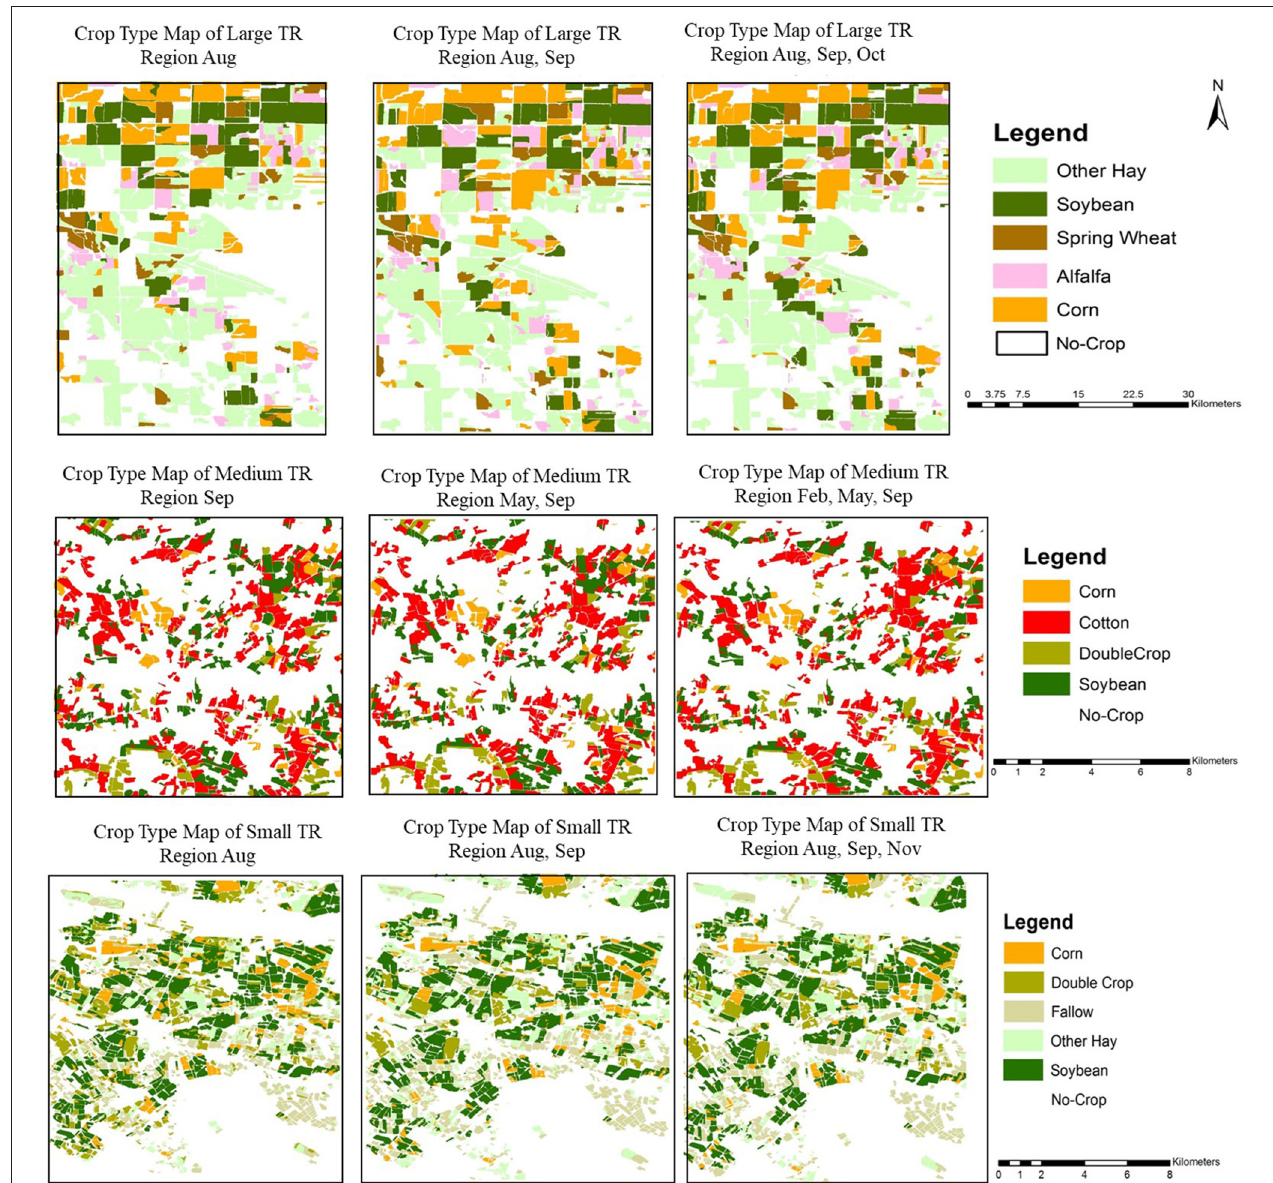
FIGURE 7 | Crop type maps of three TR regions produced from one, two, and three dates of satellite imagery in the large, medium, and small field sizes. In addition to providing additional spectral characteristics for mapping different crop types of a region, the multiple dates of satellite imagery help to identify the discrepancies and errors (e.g., omission or commission) that existed in crop type reference data. For example, the satellite imagery acquired in the month of November for the small fields size TR region shows unique spectral characteristics as dark red patches in the right lower corner ( Figure 10 ). The agriculture fields with unique spectral characteristics were expected to be some seasonal crop (e.g., cranberry growing in the month of November) and labeled as fallow land on the CDL reference data of the year 2015 ( Figure 10 ). Comparing the CDL reference data of the year 2014 and 2017 showed that these fields were labeled as